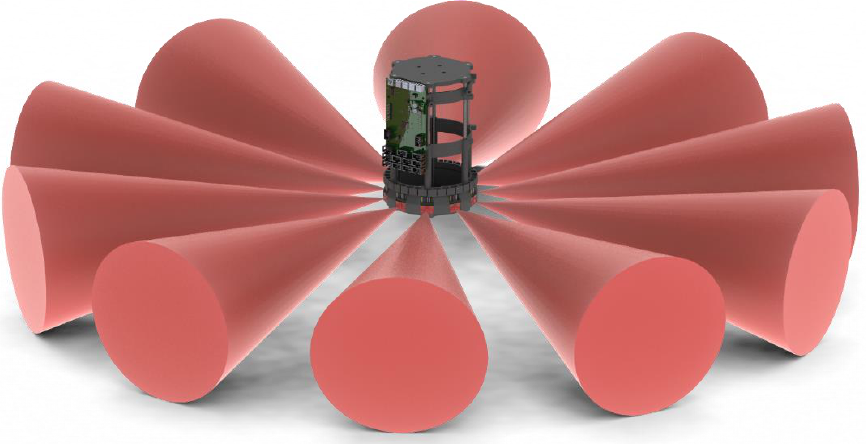
Figure 6. Visualization of cones and field of view for every VL53L1 time-of-flight sensor.